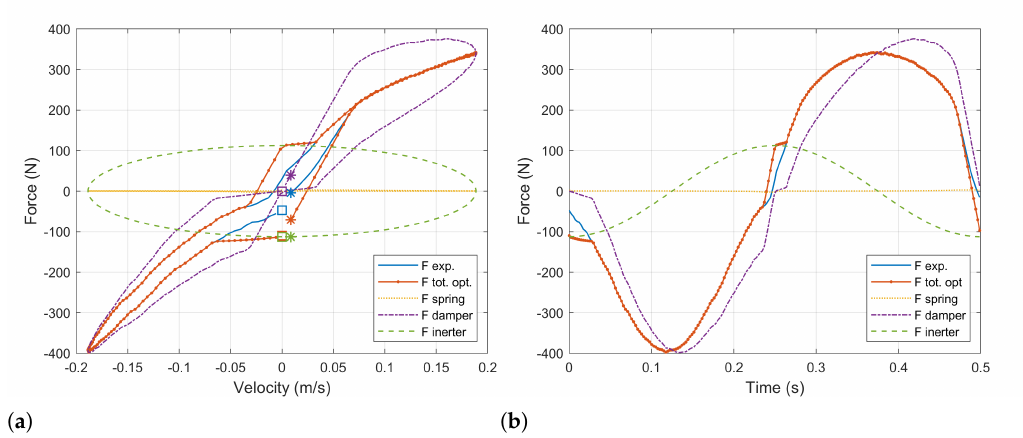
Figure 5. ( a ) Force–velocity and ( b ) force–time diagrams of the ball-screw damper with optimized external resistor ( R e ) compared to the experimental data of the baseline damper. The ball-screw damper’s force is decomposed into its components corresponding to the equivalent sprint, damper and inerter.